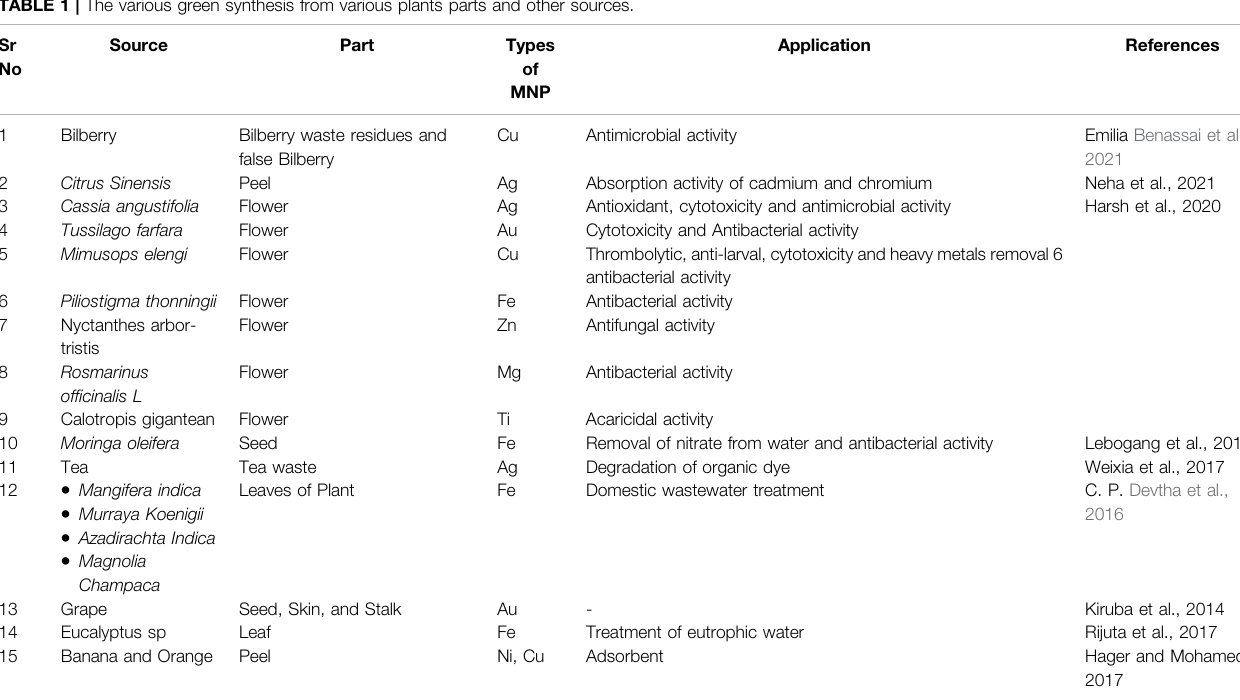
adsorbent for the aqueous solution in the wastewater treatment plant and ef fl uent showed the removal of the different magnetic property containing waste materials (Prajwall et al., 2021).